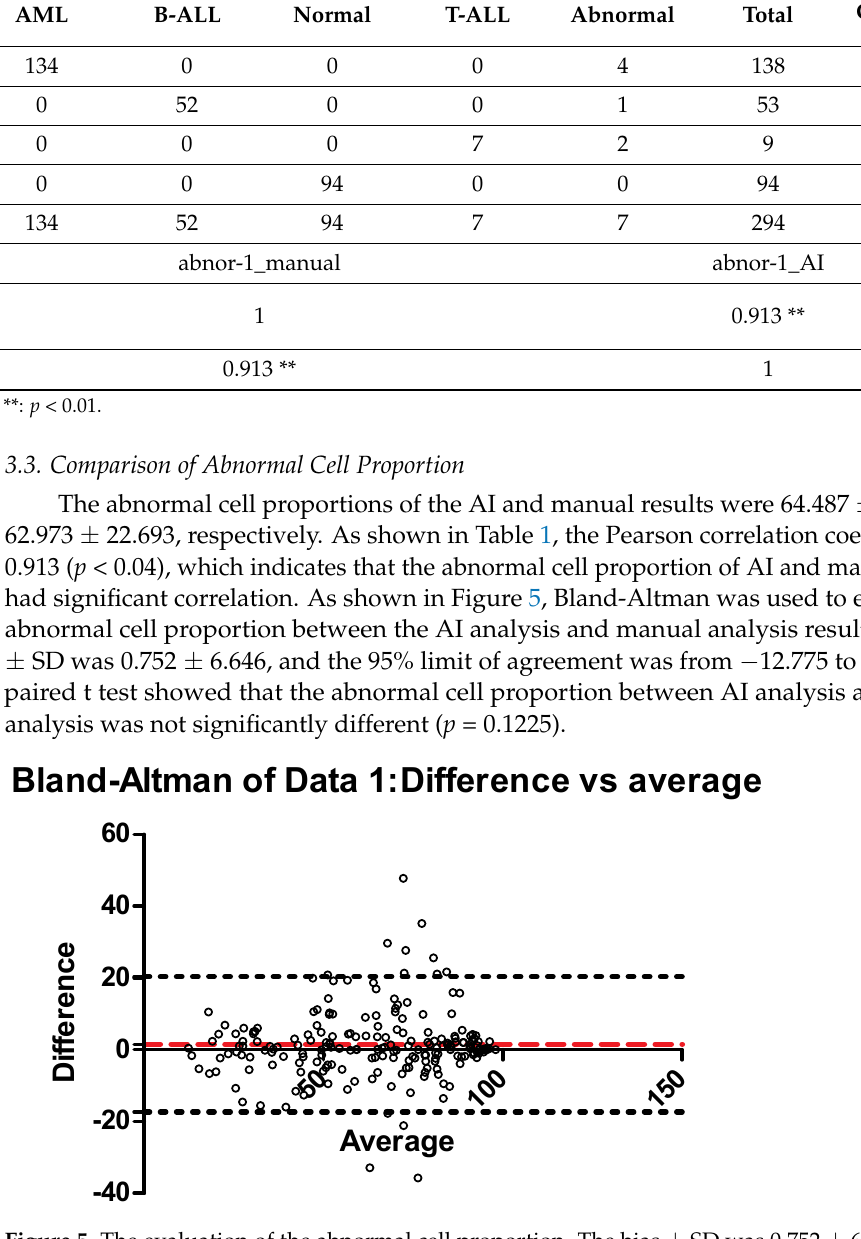
Figure 5. The evaluation of the abnormal cell proportion. The bias ± SD was 0.752 ± 6.646, and the 95% limit of agreement was from − 12.775 to